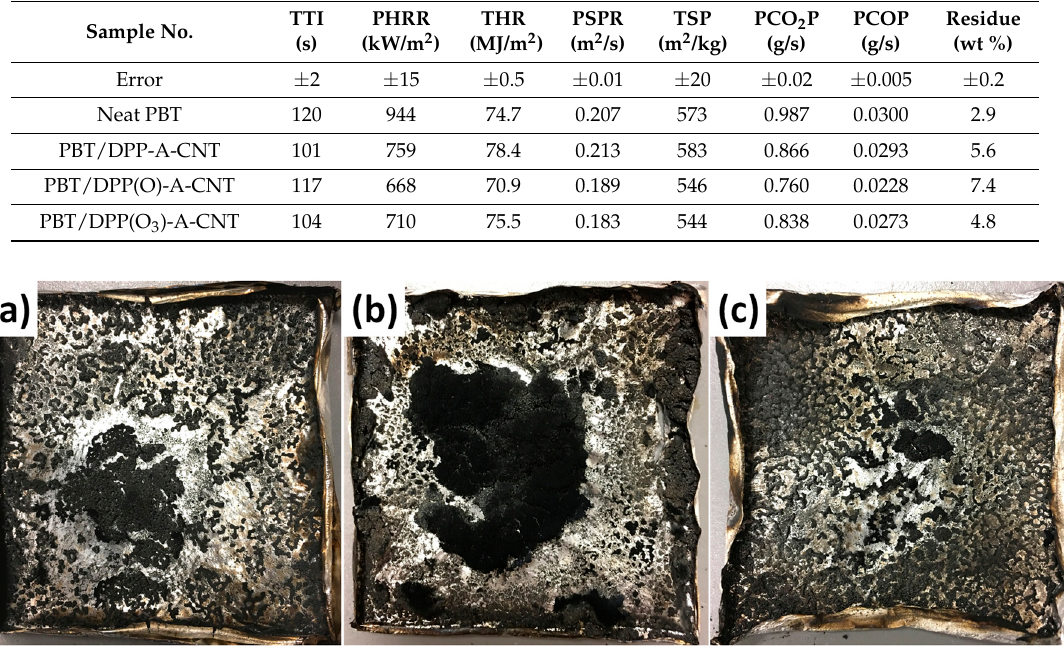
Figure 9. Digital photographs of the residues after cone calorimeter tests: ( a ) PBT/DPP-A-CNT; ( b ) PBT/DPP(O)-A-CNT; and ( c ) PBT/DPP(O 3 )-A-CNT.